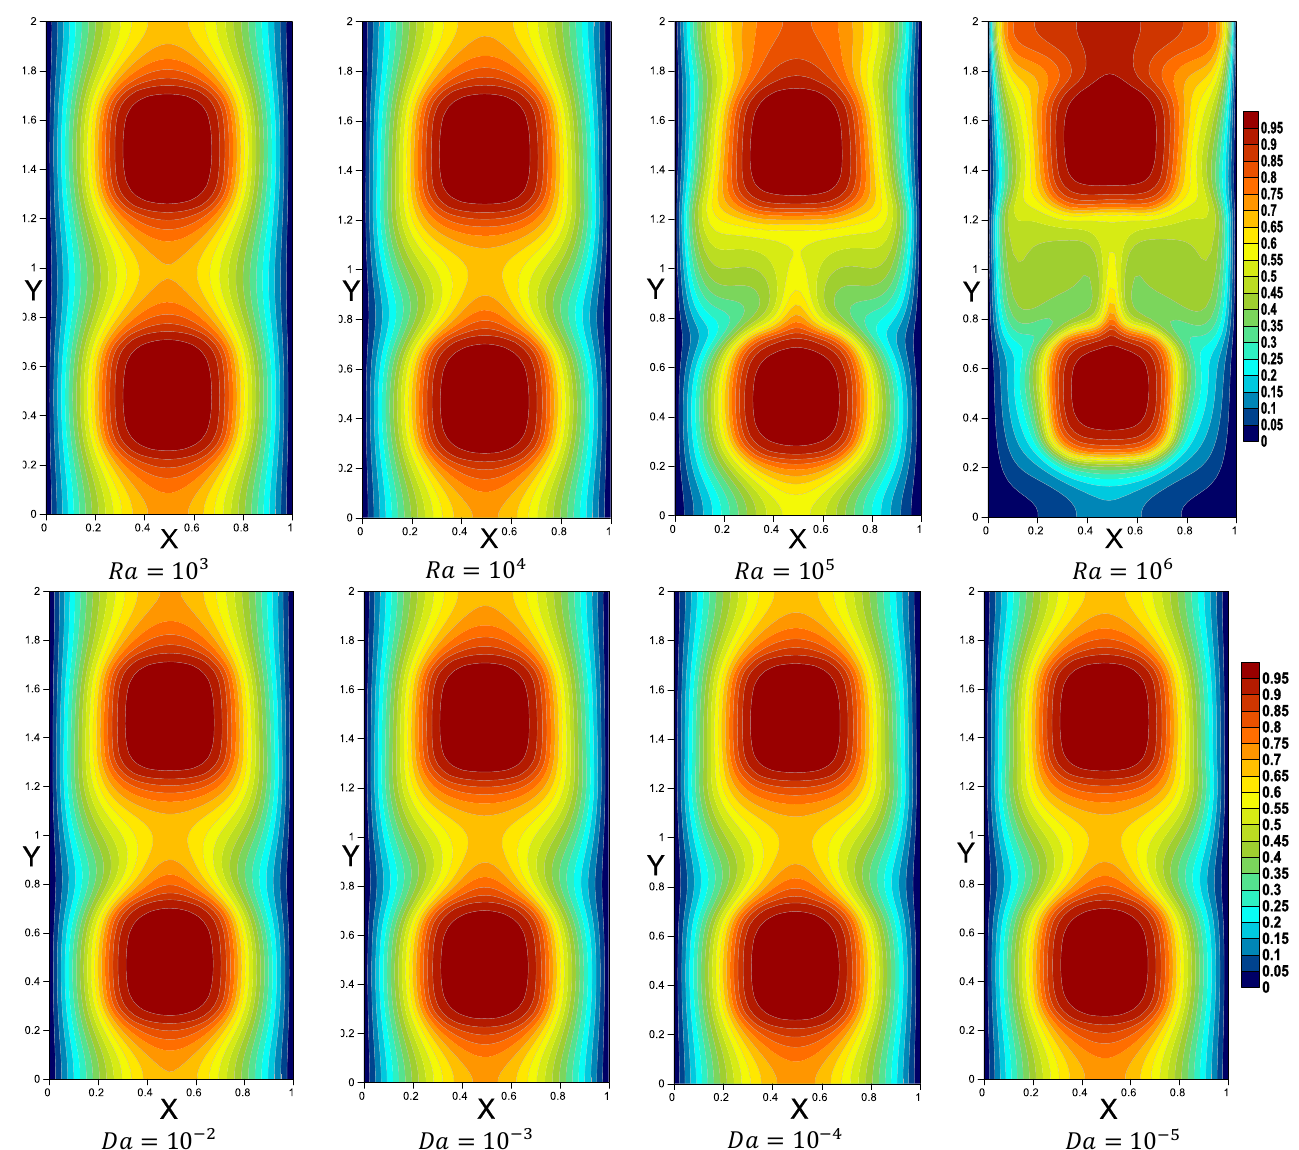
Figure 5. The temperature below the variations of the shape of superellipse enclosures, porosity, Rayleigh number, and Darcy number.